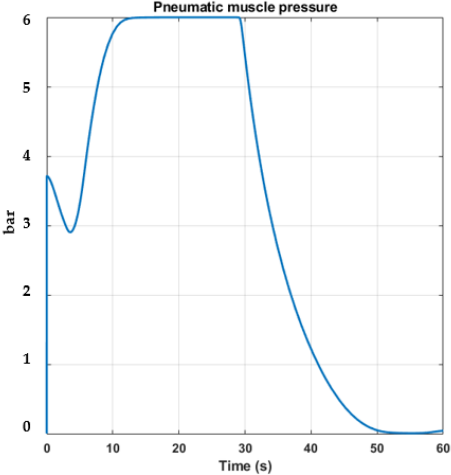
Figure 9. Variation versus time of the pneumatic muscle feed pressure.